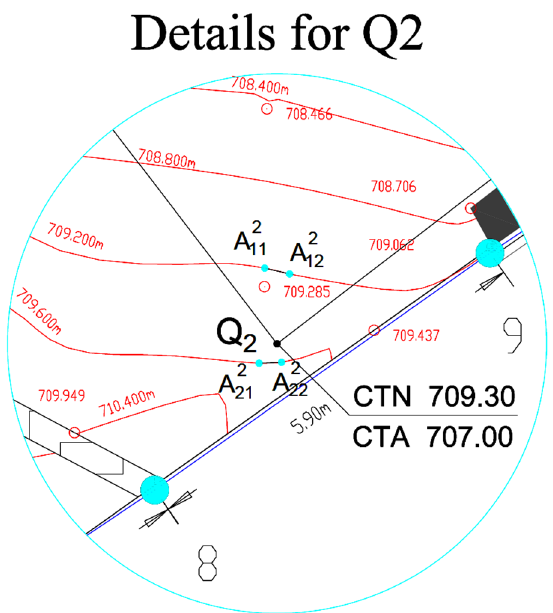
Figure 12. Detail of Figure 11 for Q 2.